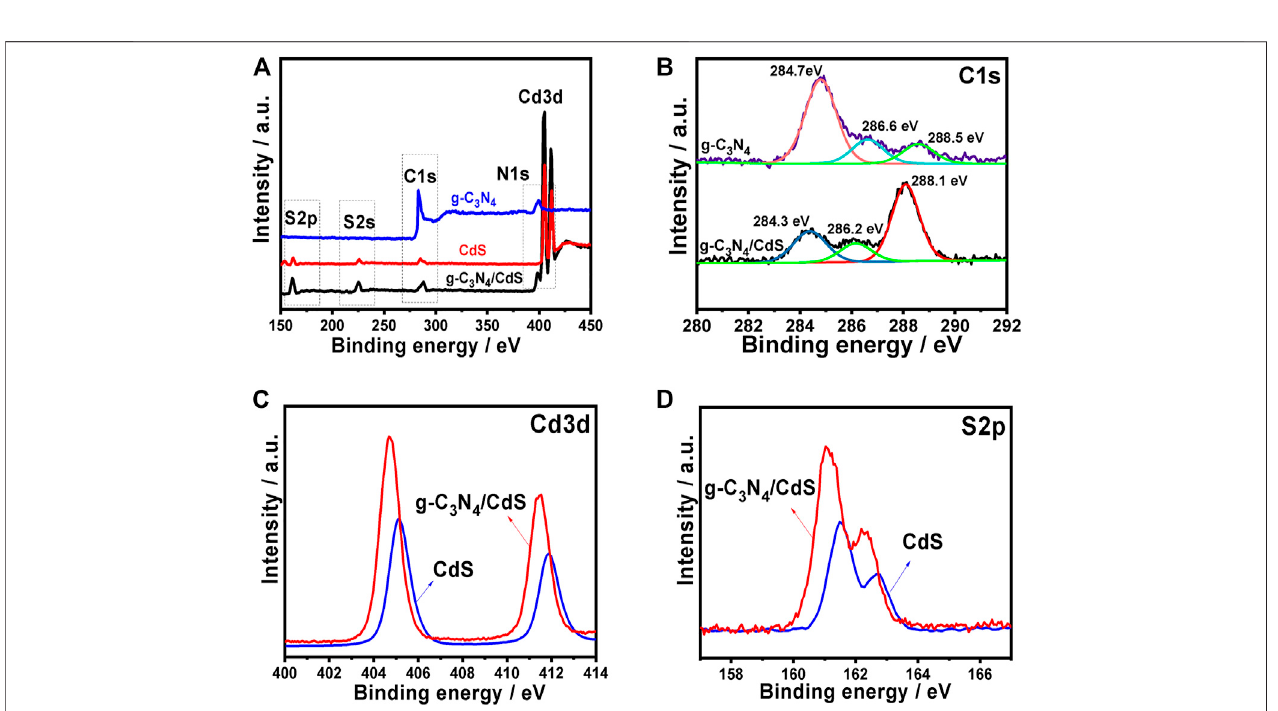
Frontiers in Chemistry |